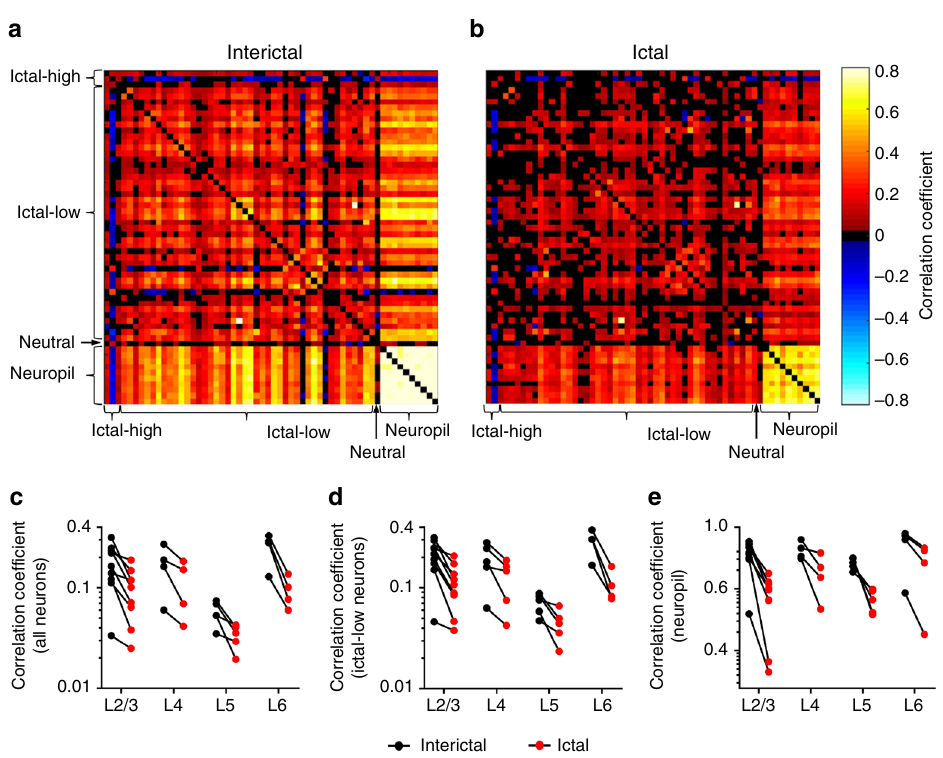
Fig. 4 Pairwise synchrony is reduced in the ictal state. Pairwise correlation coef fi cients from a representative example of L2/3 neurons and neuropil in the a interictal and b ictal states. Across all data sets in all layers, there was a signi fi cant reduction in synchrony in the ictal state for c all neurons, d ictal-low neurons, and e neuropil ( p < 0.005, Wilcoxon matched-pairs signed rank test)